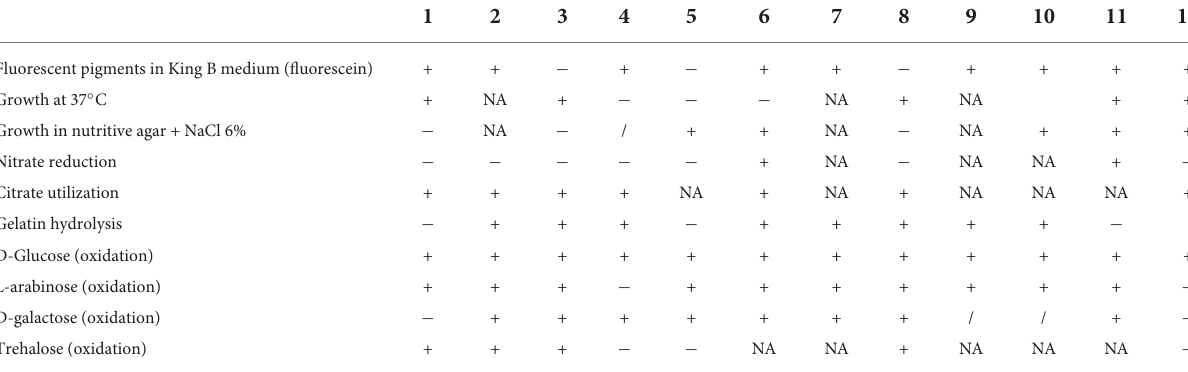
Taxons:1: Pseudomonasatacamensis M7D1;2: P.moraviensis LMG24280;3: P.granadensis LMG27940;4: P.baetica LMG25716;5: P.crudilactis UCMA17988T;6: P.koreensis LMG21318; 7: P.atagonensis PS14;8: P.iridis P42;9: P.allokribbensis LMG31525T;10: P.gozinkensis LMG31526;11: P.laurylsulfativorans AP3_22;12:SAICEUPSM T ;+:positive; − :negative;/:weak;